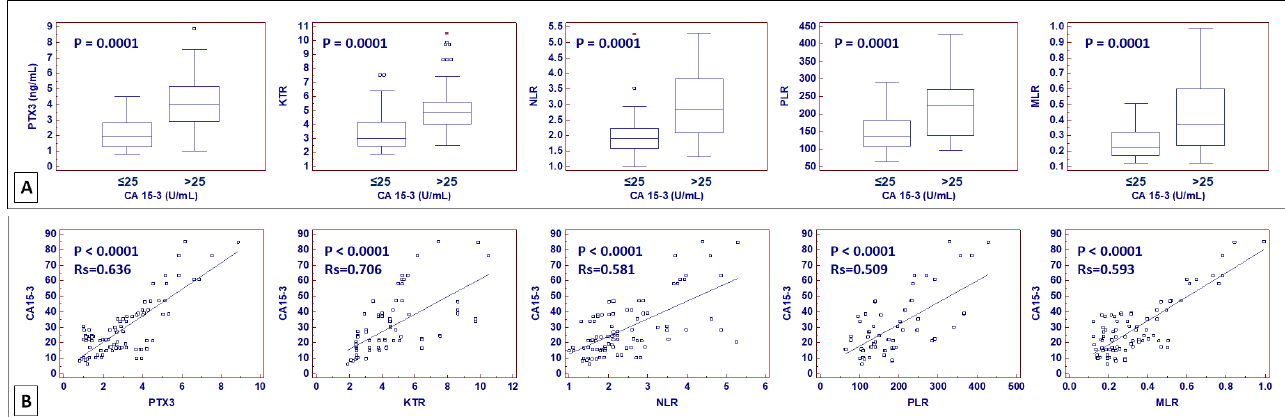
Figure 12. Box-and-whisker plots of pentraxin 3 (PTX3) serum levels, kynurenine-to-tryptophan ra- tio (KTR), neutrophil-to-lymphocyte ratio (NLR), platelet-to-lymphocyte ratio (PLR), and mono- cyte-to-lymphocyte ratio (MLR), stratified according to CA15-3 values ( ≤ 25 vs. >25 U/mL) ( A ). Scatter diagrams with regression line for correlation analysis between CA15-3 and PTX3, KTR, NLR, PLR, and MLR ( B ).